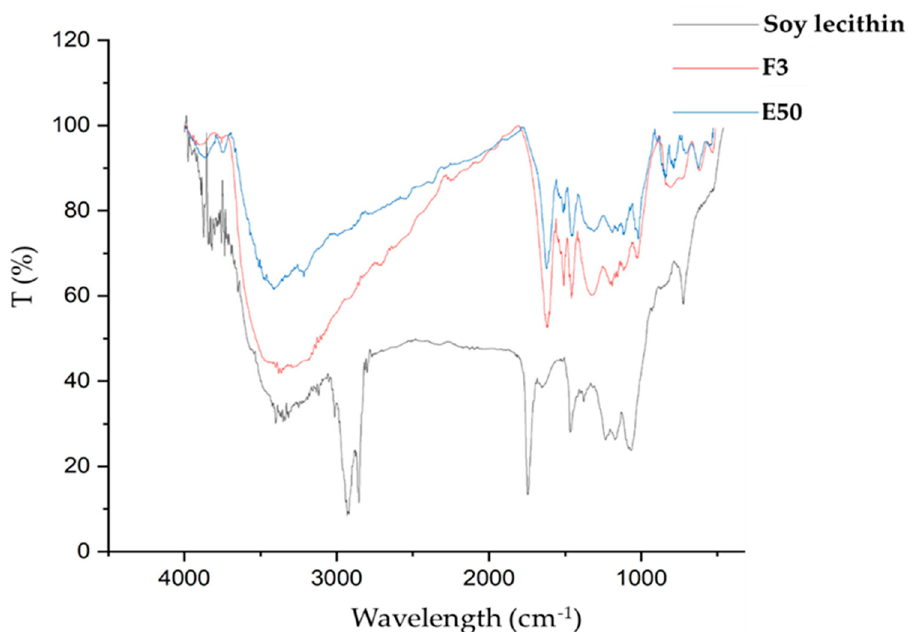
Figure 2. FTIR spectrum of E50, soy lecithin, and